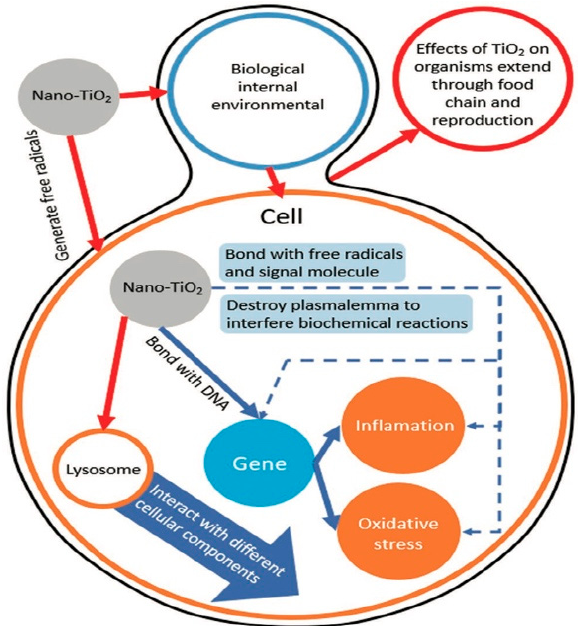
Figure 2. Toxicity mechanism of the reaction of TiO 2 NPs with cells. Adapted with permission from [28]. Copyright, 2020 John Wiley & Sons, Inc.